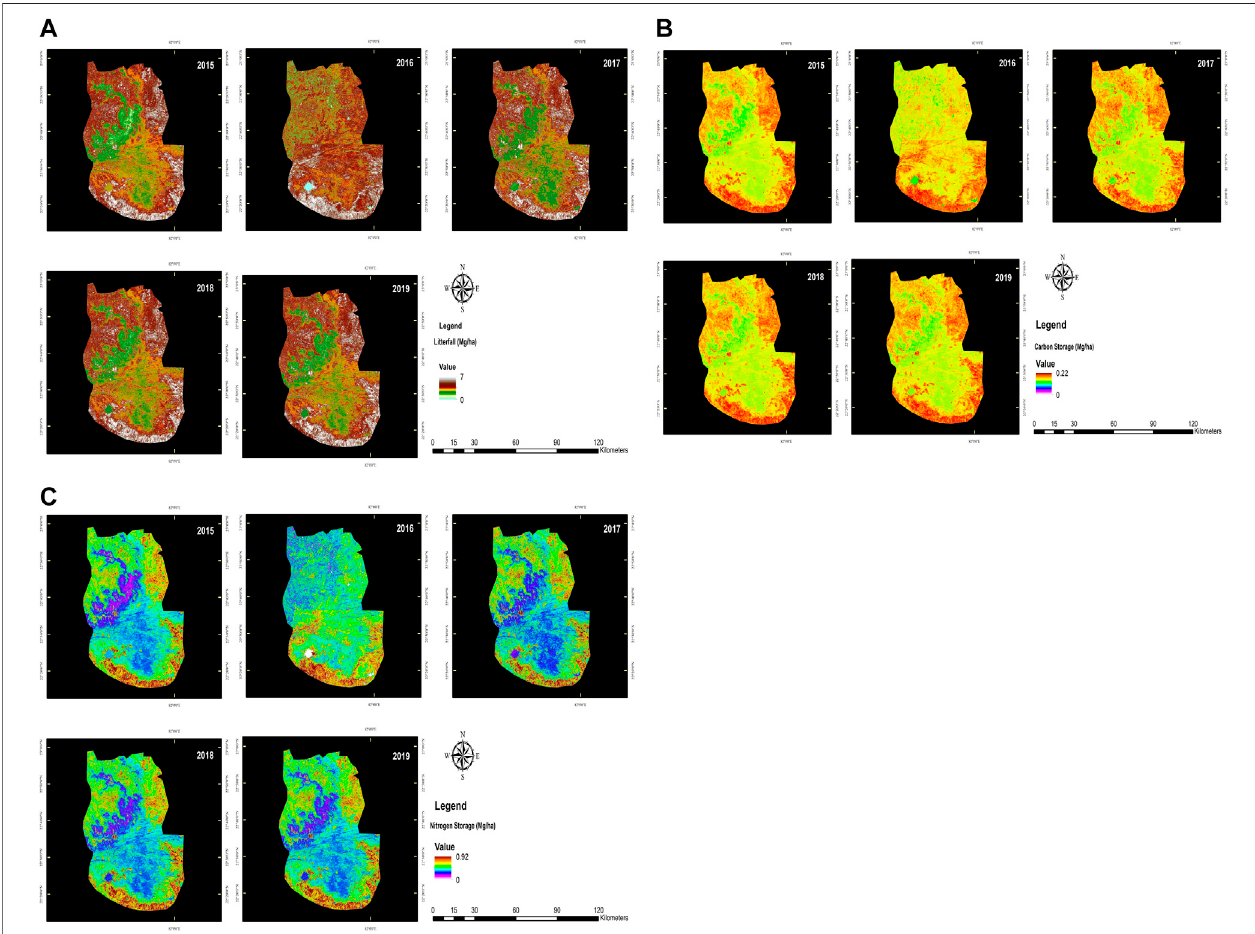
FIGURE 6 | Understanding sustainability-estimation of annual litterfall (Mg/ha), carbon and nitrogen storage (Mg/ha) under different vegetation types in AABR. (A) : annual litterfall (Mg/ha); (B) : carbon storage (Mg/ha); (C) : nitrogen storage (Mg/ha).